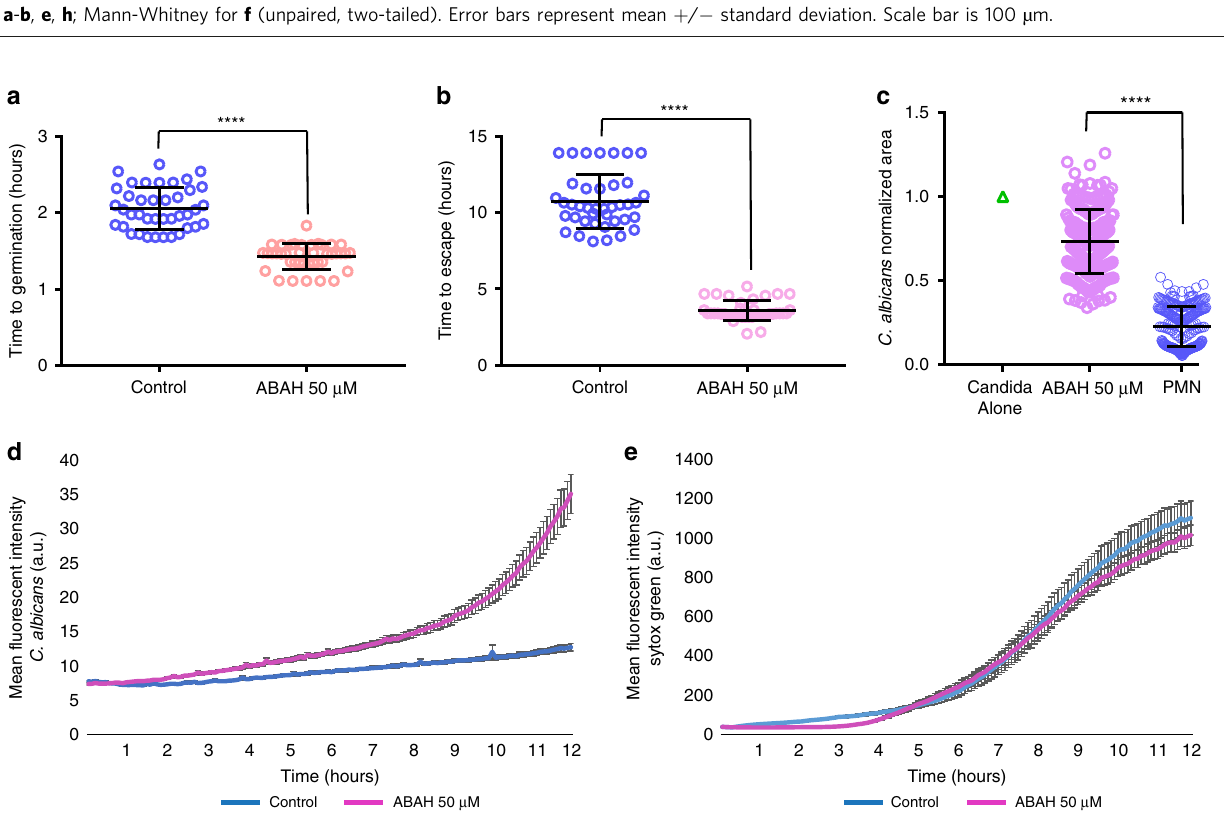
Fig. 4 NADPH oxidase function plays a critical role in swarm dynamics. Human neutrophils were incubated with different inhibitors to interrogate the mechanisms necessary to restrict the growth of C. albicans during swarming. The inclusion of 300 µ M Apocynin disrupted the ability of neutrophils to swarm to C. albicans , while the inclusion of 10 µ M DPI resulted in rapid formation and then dissolution of swarms, as shown in quanti fi cation of the neutrophil accumulation area. N = 36 swarms across 3 donors for DPI, N = 48 across 3 donors for Apocynin ( a ). The area of fungal growth after swarming with ROS inhibitors at 16 hours shown ( b ). N = 288 swarms for PMN, 96 swarms for Trolox, 286 swarms for Apocynin and 219 spots for the no PMN group, across 3 independent donors. CGD neutrophils exhibit exaggerated swarming at early points in the assay as shown in a panel of representative images and in the quanti fi cation of neurophil swarming area ( c – e ). N = 16 swarms for one donor for control and N = 46 swarms across three donors for CGD. The area of fungal growth after swarming with control or CGD neutrophils after 16 hours is shown ( f ). Results are normalized to growth of the C. albicans alone control. N = 96 swarms for one donor for control and N = 288 swarms across three donors for CGD. CGD samples exhibit reduced NETs. The MFI of Sytox Green staining was quanti fi ed for swarms from a healthy donor and from CGD neutrophils ( g ). Average of 16 swarms for control and 16 swarms for each individual CGD sample is shown. The number of nuclei/ µ m 2 was quanti fi ed and is shown ( h ). N = 16 swarms for one donor for control and N = 16 swarms for